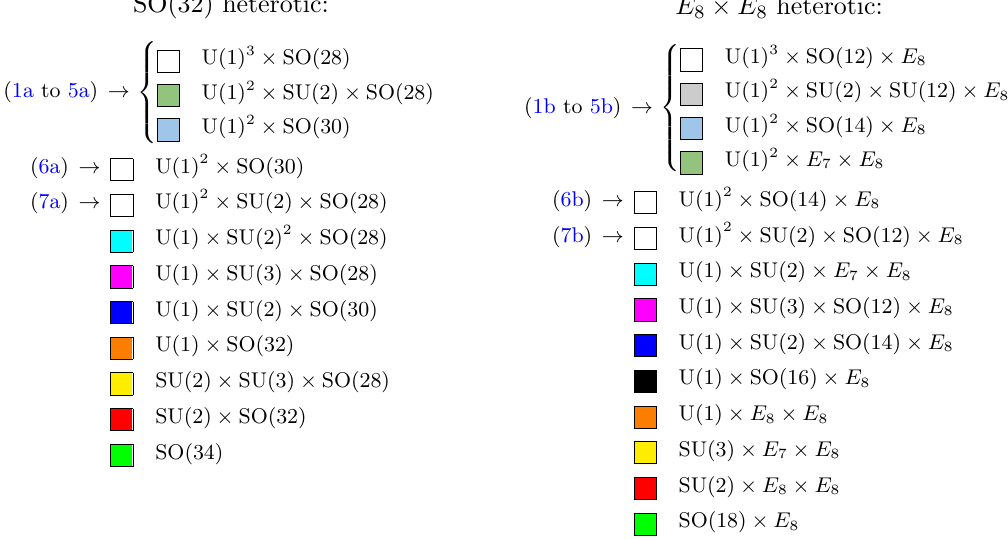
Table 3. Groups corresponding to the colours in (cid:12)gures 1 to